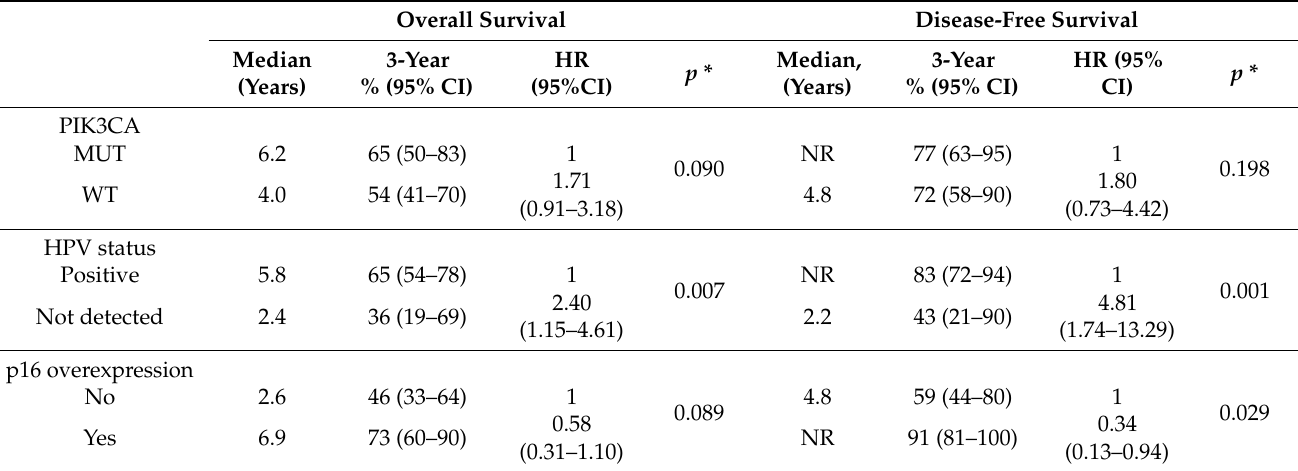
Table 4. PIK3CA mutation, HPV, and p16 status association with the overall and disease-free survival by univariable analysis.